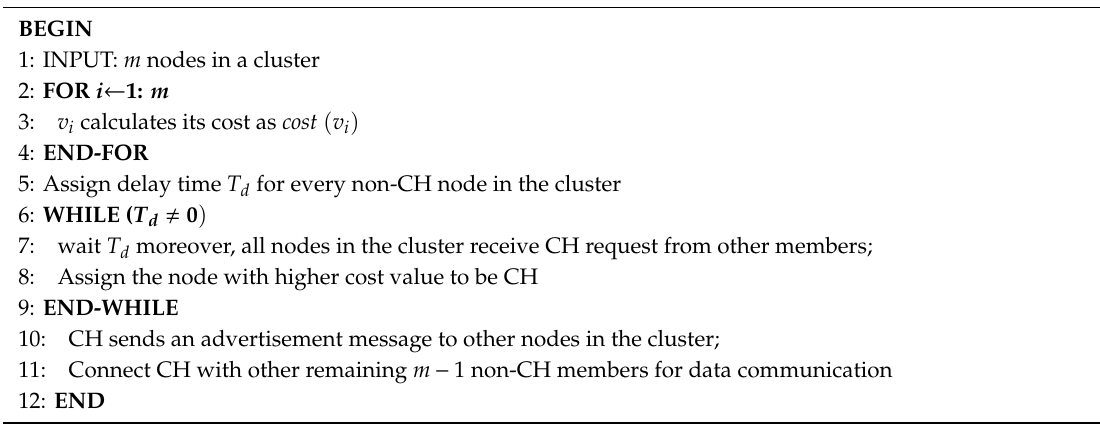
Algorithm 2: Selection of Cluster